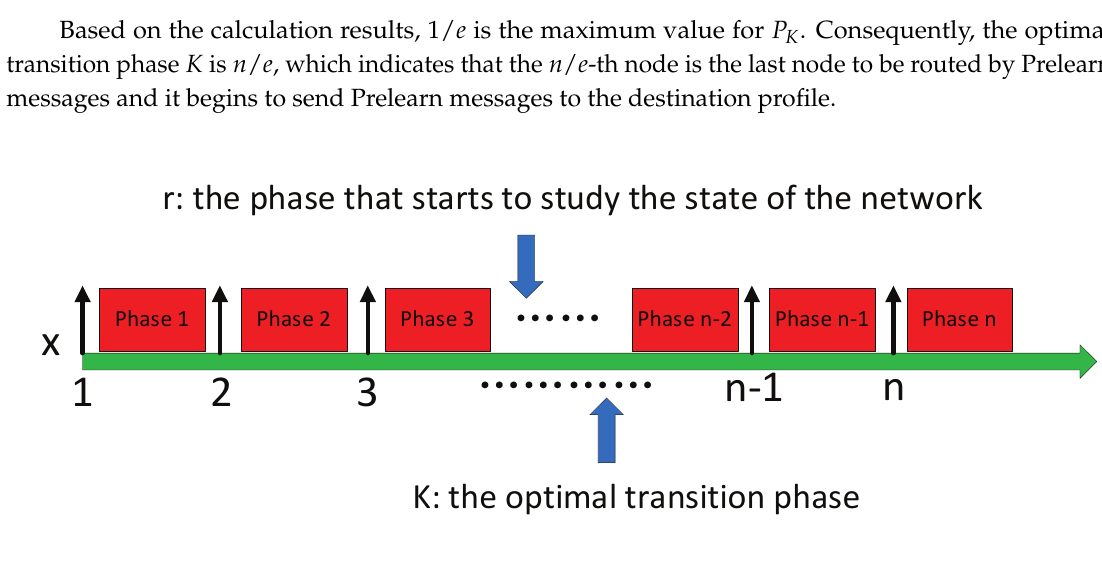
Figure 3. The optimal transition phase between Predict and